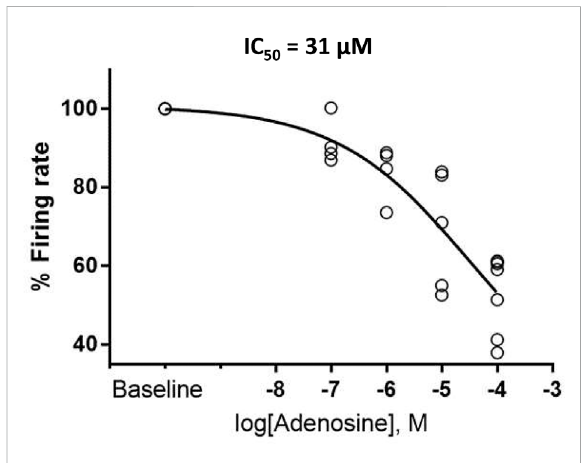
FIGURE 2 Adenosine slows the fi ring rate of rhythmically fi ring SANC in a dose-response manner. The IC 50 for our dose response curve was 31 µM adenosine. ( n = 4 for 100 nm and 1 µM adenosine, n = 5 for 10 µM adenosine, and n = 7 for 100 µM adenosine). The dataof fi ringrateresponsewerenormalizedtobebetween0%and 100% of baseline and fi tted to Variable slope model using GraphPad program https://www.graphpad.com/guides/prism/ latest/curve- fi tting/reg_dr_inhibit_normalized_variable.htm. The equation for this fi tting function was: Y = 100/(1 + 10 ^ ((LogIC50-X) *HillSlope)].